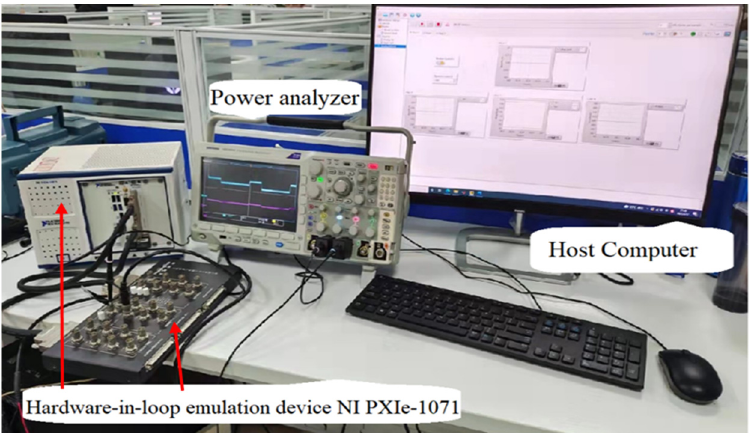
Figure 20. Hardware-in-the-loop experiment hardware configuration.